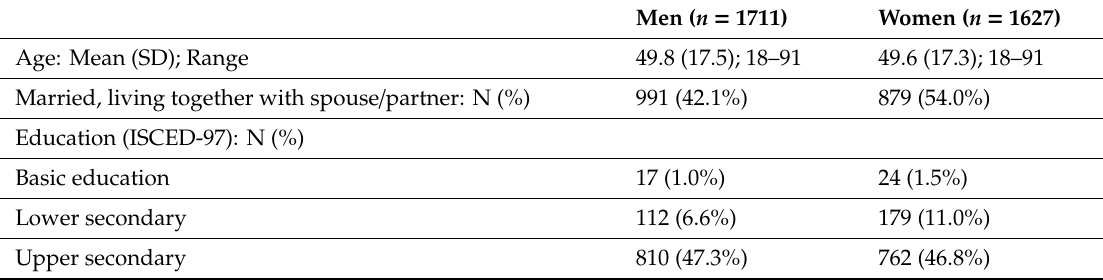
Table 1. Sample characteristics for the individuals included in negative binomial regressions stratified by sex ( n =